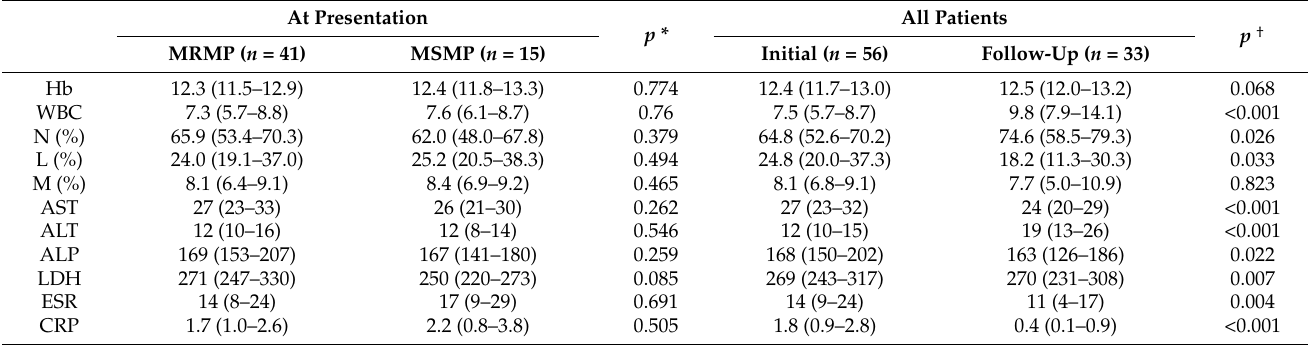
Table 2. Comparison of laboratory findings during